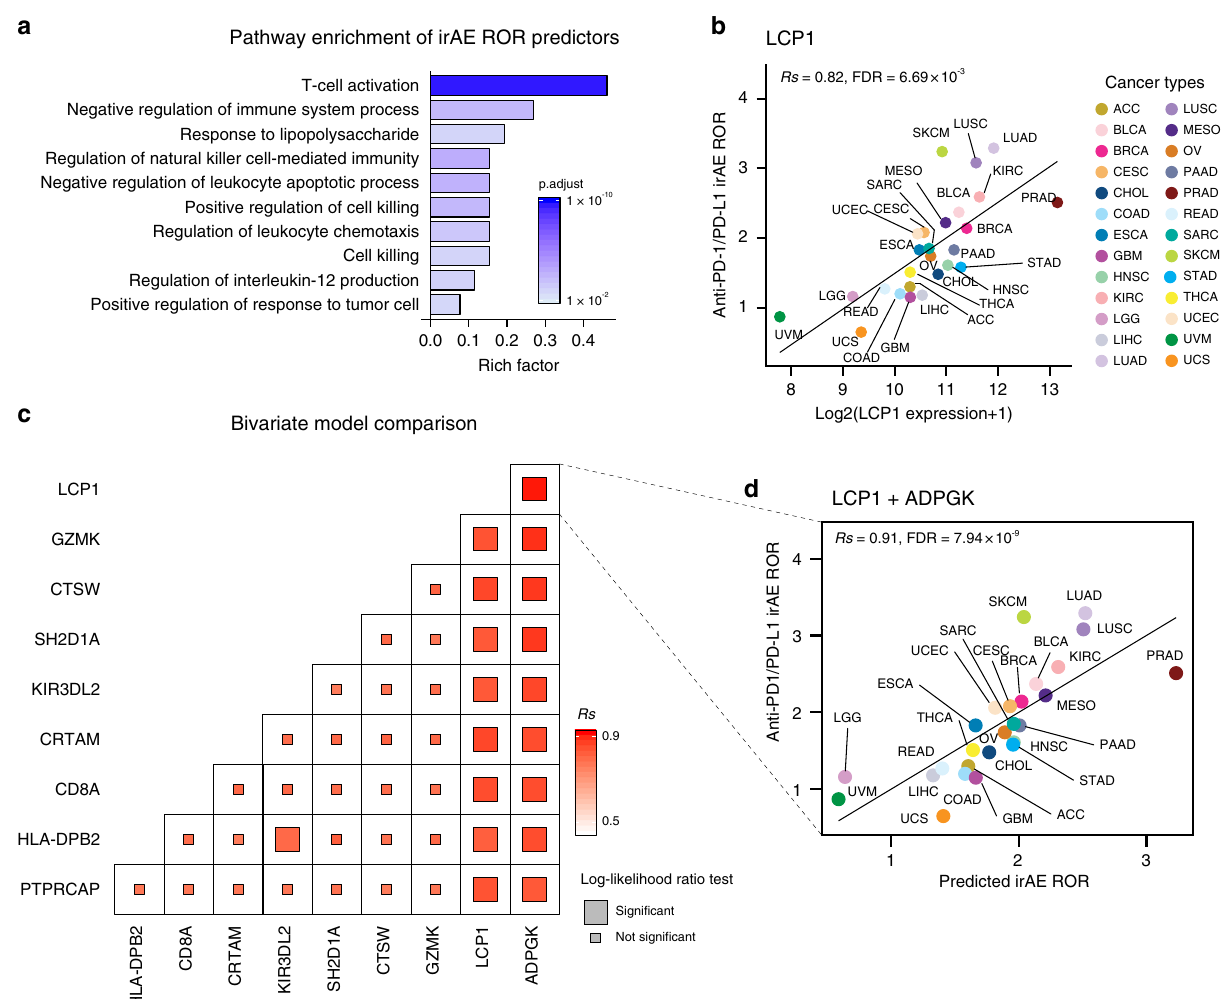
Fig. 2 Comprehensive identi fi cation of potential irAE predictors. a Pathway enrichment of the top ten genes signi fi cantly correlated with irAE ROR across multiple cancer types. b Spearman correlation between LCP1 expression and irAE ROR. c Comparison of performance of bivariate models in predicting irAE for all combinations of the top ten irAE ROR signi fi cantly correlated genes. Spearman correlation ( Rs ) was calculated between the predicted and observed irAE ROR. The shade of the square indicates the Rs , and the size indicates the signi fi cance of the log-likelihood ratio test. d Combined effect of LCP1 and ADPGK bivariate model (Spearman correlation, Rs = 0.91, FDR = 7.94 × 10 − 9 ). The equation of the bivariate regression model is 0.37 × LCP1 + 0.70 × ADPGK –